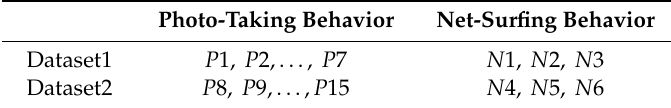
Figure 9. Visual skeleton information of net-surfing behavior. ( a ) Initial position of subject’s arm; ( b ) before subject starts the net-surfing behavior; ( c ) when subject is surfing the Internet on smartphone (during net-surfing behavior); ( d ) when subject finishes net-surfing behavior. Table 2. Obtained datasets from experiments